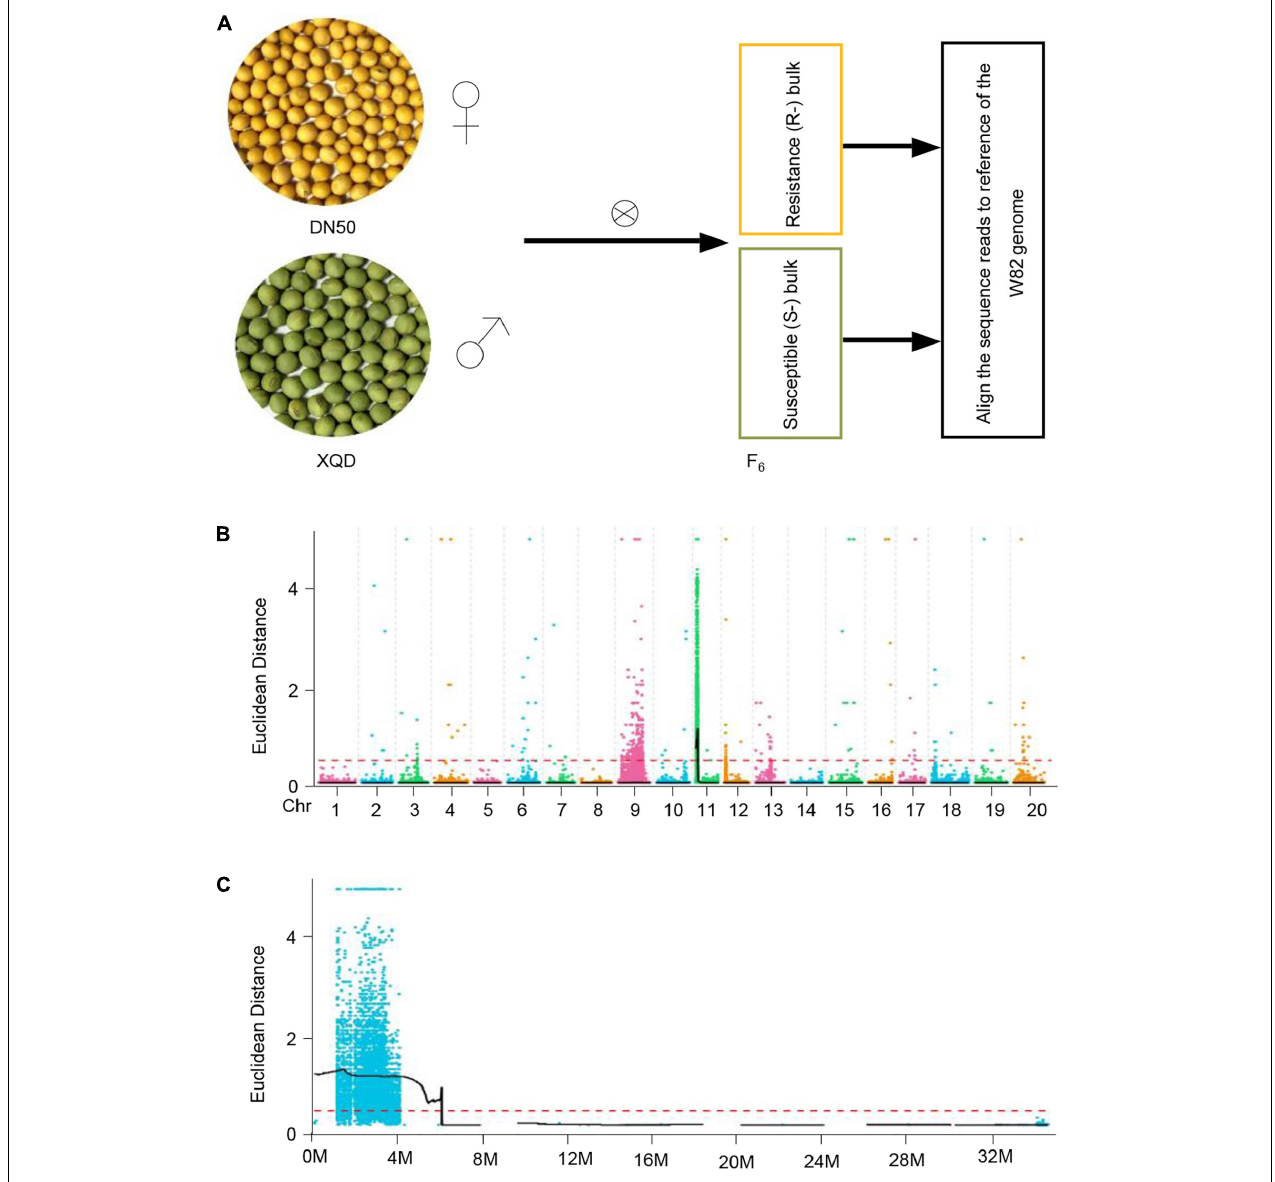
FIGURE 2 | A simplified scheme of BSA-seq as applied to soybean. (A) Morphological difference in seed size between DN50 and XQD accessions. Two cultivars with different phenotypes are crossed to generate F6 progeny segregating for the trait value. Multiple progeny exhibiting resistance and susceptibility to SC7 are selected, and their DNA is bulked to produce “Resistant” and “Susceptible” bulks, respectively. (B) Examples of Euclidean distance (ED)-associated values on chromosomes. The color points represent the ED value of each single-nucleotide polymorphism (SNP) locus. The black line is the fitted ED value, and the red dotted line represents the significantly associated threshold. Higher ED values indicate stronger correlations. (C) The distribution of Euclidean distance (ED)-associated values on chromosome